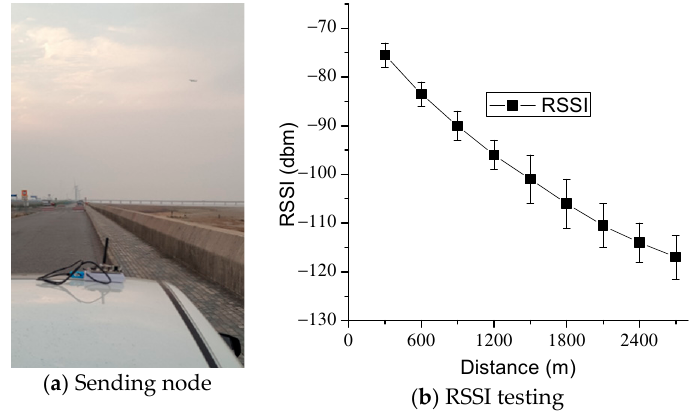
Figure 6. The measurements of the relationship between RSSI and distance.